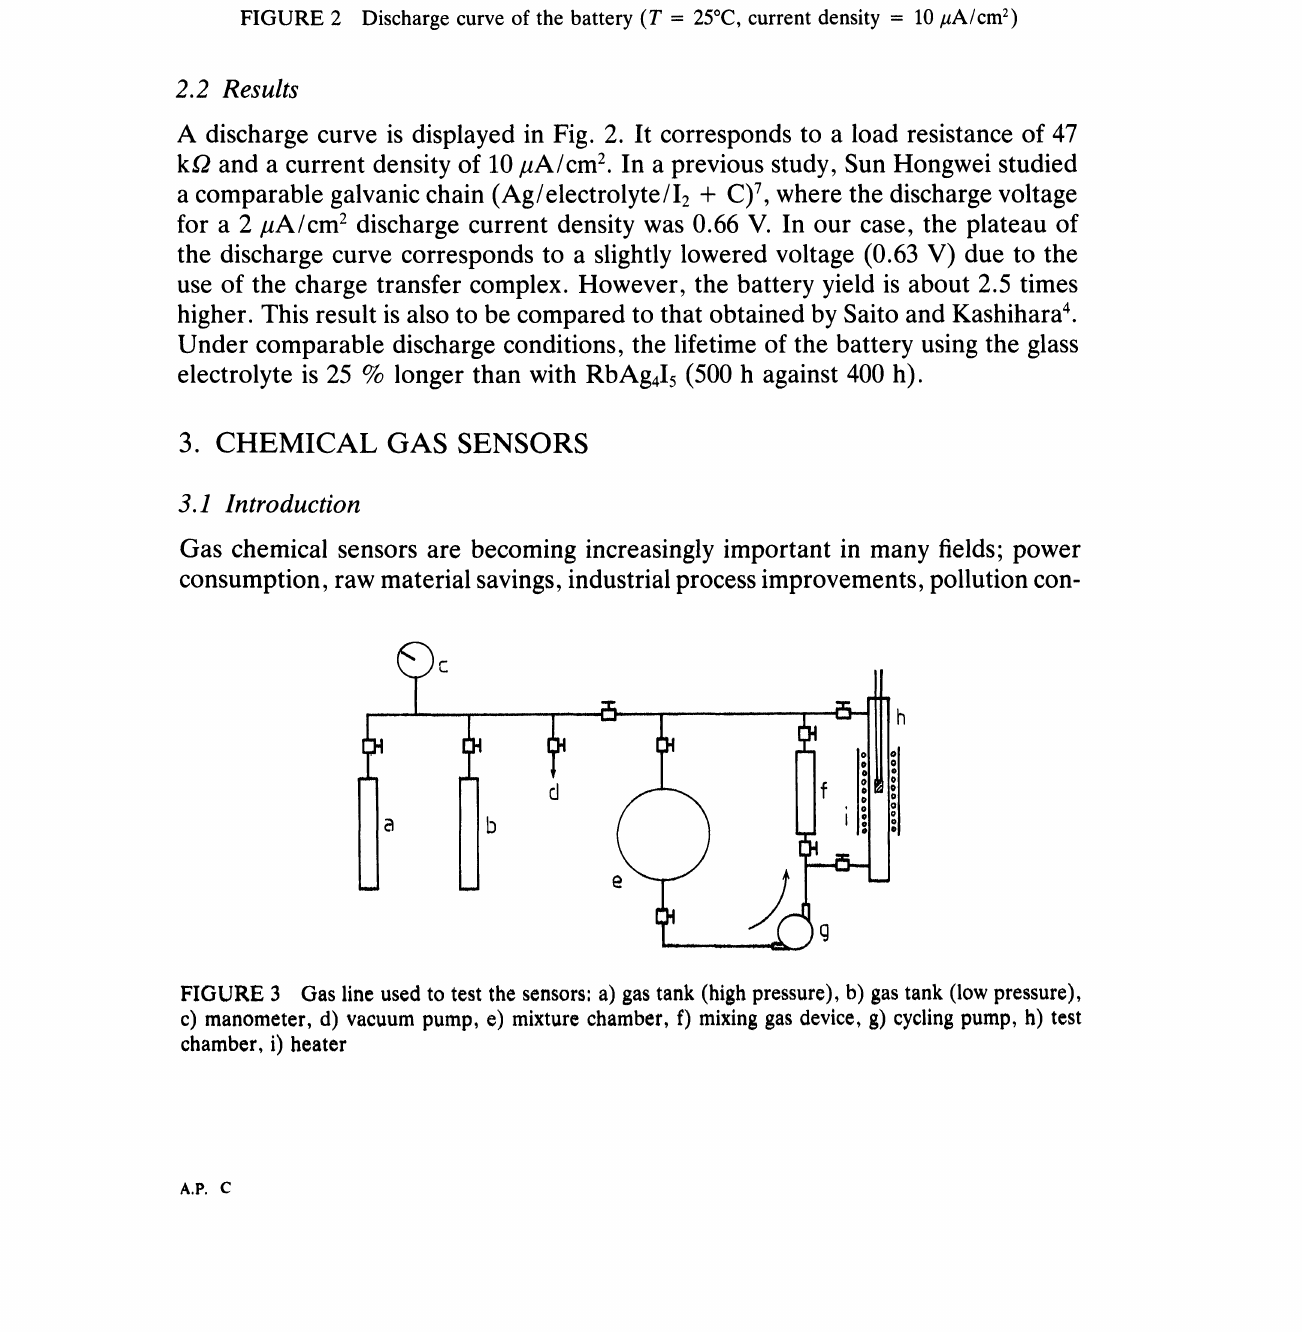
FIGURE 2 Discharge curve of the battery (T 25C, current density 10/tA/cm